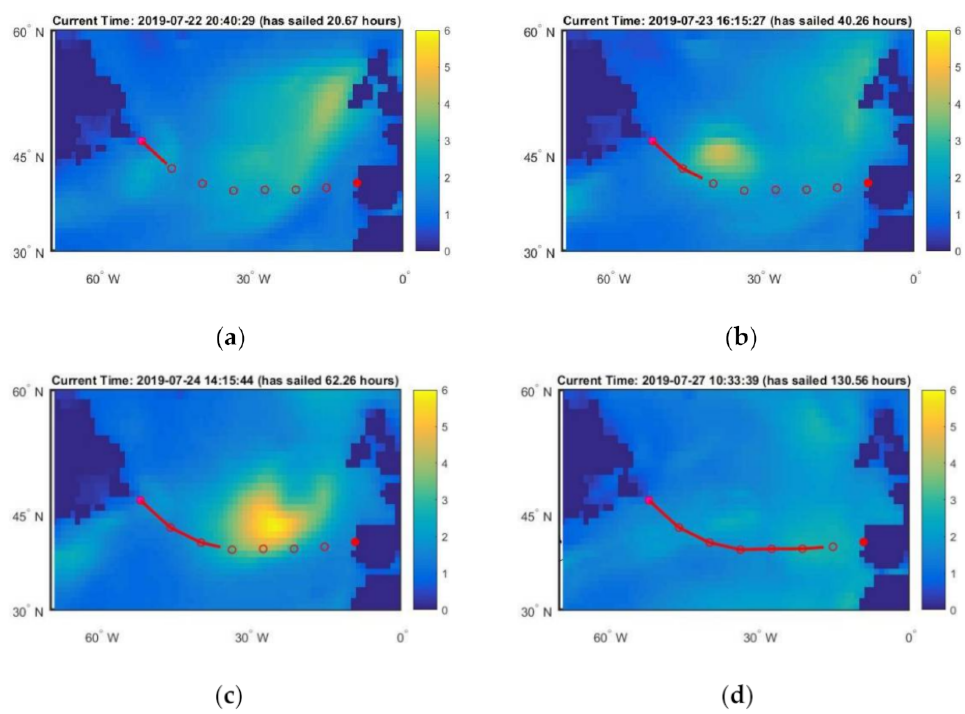
Figure 10. Position of the ship in severe conditions at four different navigation times. ( a – d ) show the position of the ship with respect to the wave height map at different times.